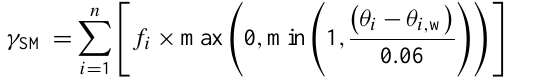
Fig. 4. Cumulative yields of HCHO per unit carbon from isoprene oxidation as a function of time in the DSMACC chemistry box model using the standard GEOS-Chem chemistry scheme (red), the Paulot scheme (blue), and the standard scheme with artificial gen- eration of OH from isoprene hydroperoxide (ISOPOOH) oxidation (green) for different NO x levels initialized at local noon. Details on the box model simulation are given in the